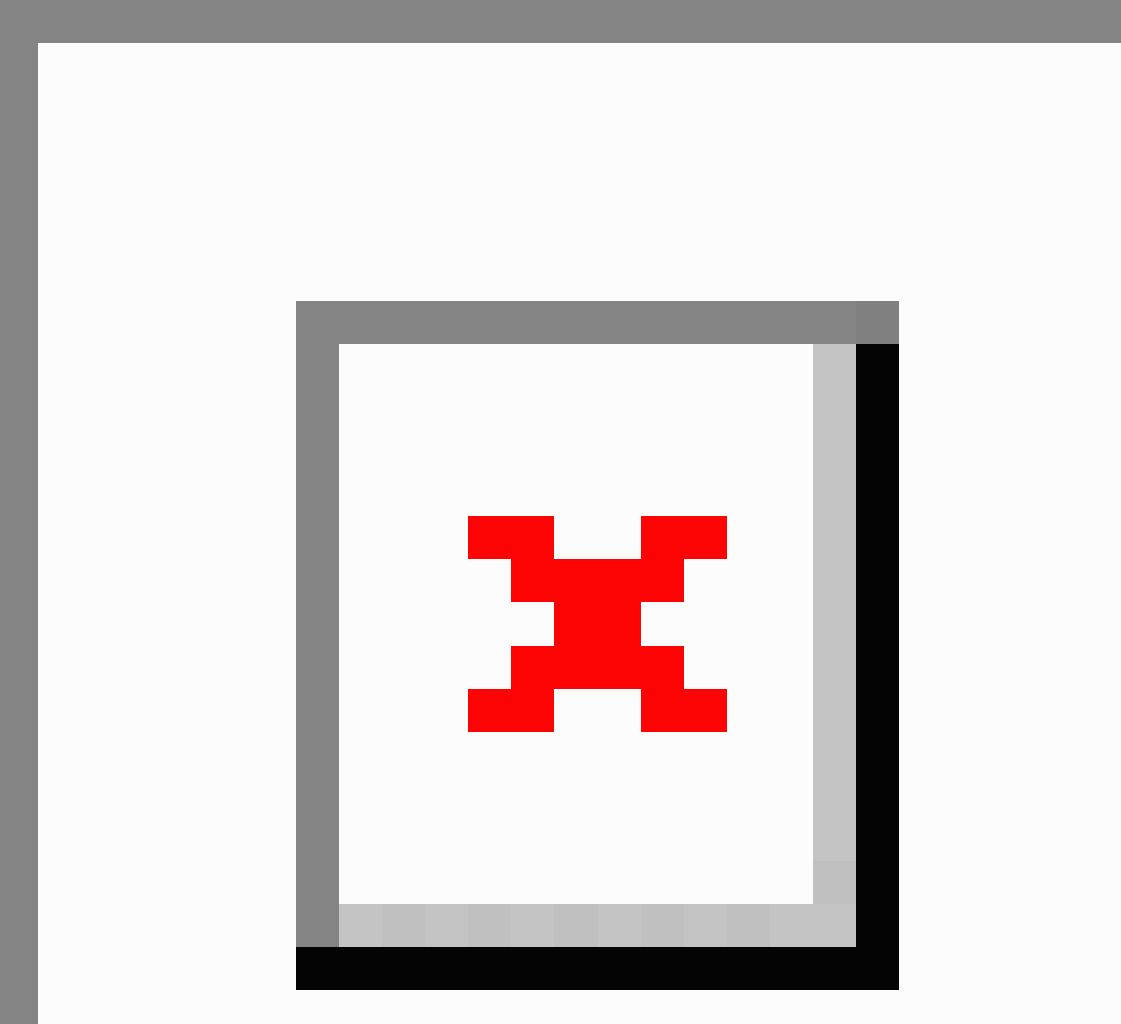
Figure 8. The experiment venue. Markers on the floor indicate the start and end points and numbered reference points for standing in a predefined orientation. Additional markers also show which part of the area is covered by which Kinect